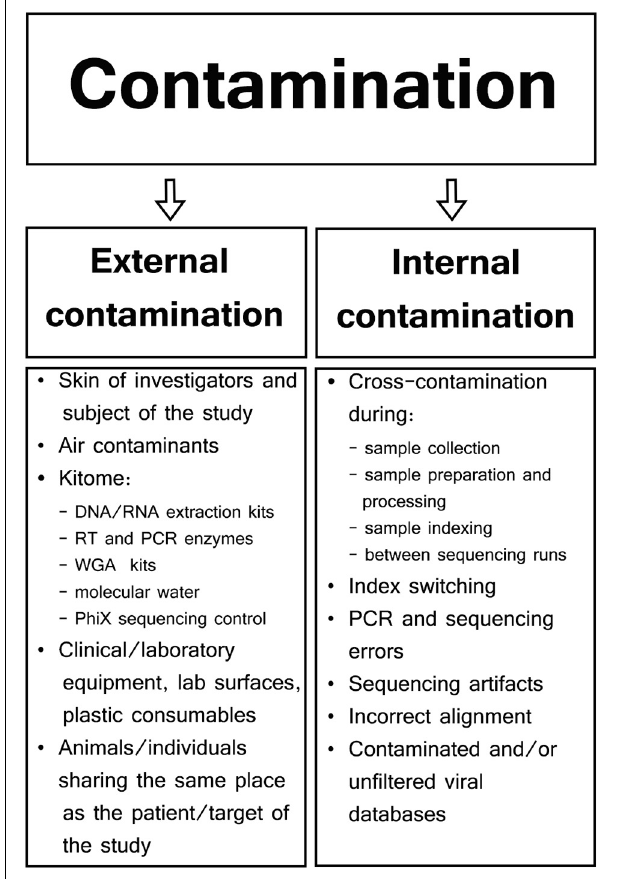
FIGURE 1 | Types and sources of contamination in viral metagenomic